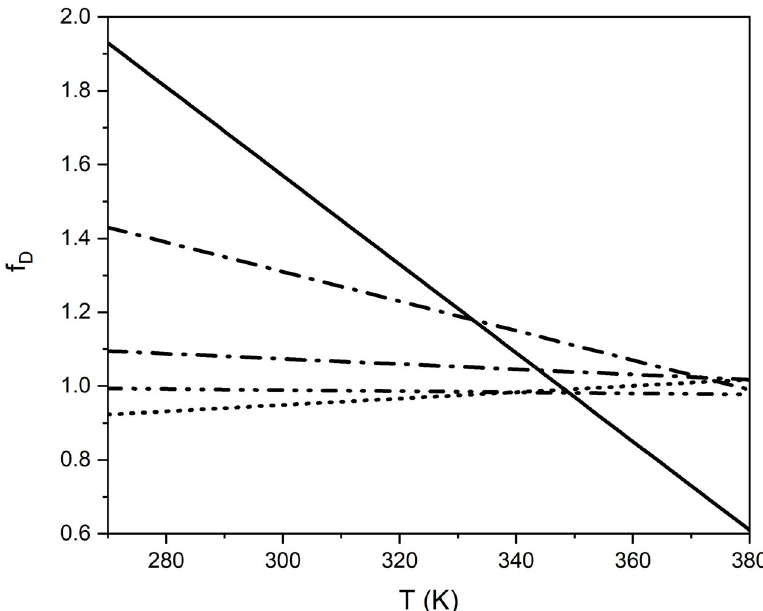
Figure 7. The factors f D = a D + b D T in Equation (25) for the self-diffusion of 5 compounds as a function of temperature T K. From bottom to the top at low temperatures: n-heptane, ethyl-acetate, benzene, methanol, water .